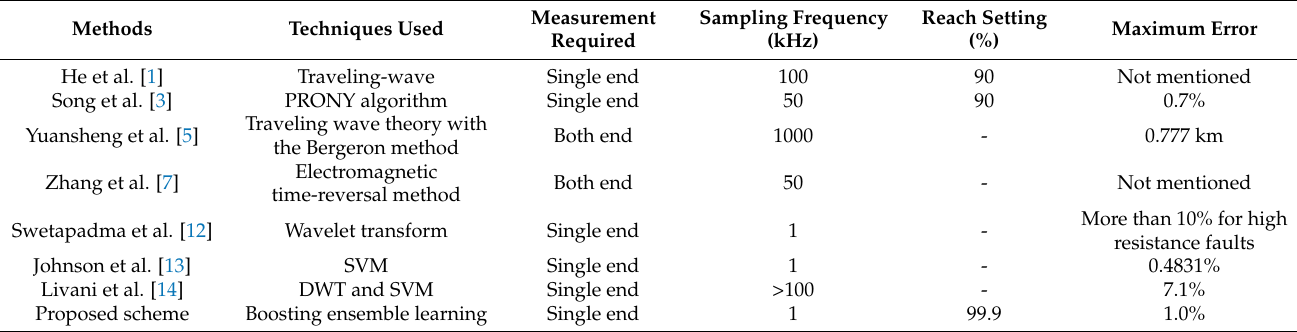
Table 8. Comparison with other